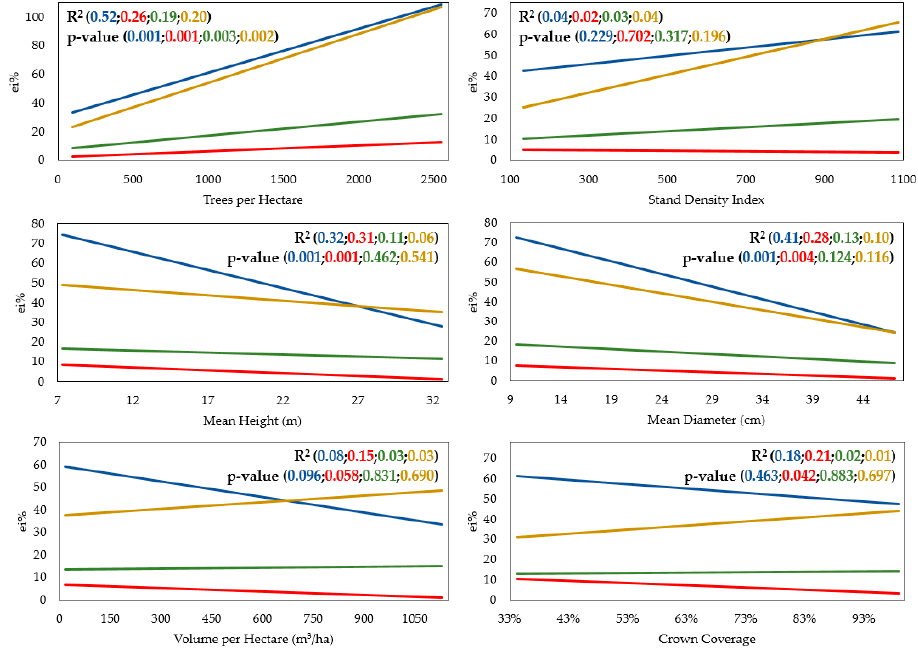
Figure 7. Regression between selected stand characteristics (X-axis) and relative individual difference (Y-axis) of remotely-sensed number of tree (blue), mean height (red), mean diameter (green), and volume (brown). The figures contain coefficients of determination ( R 2 ) and F -test of statistical significance of the regression model ( p